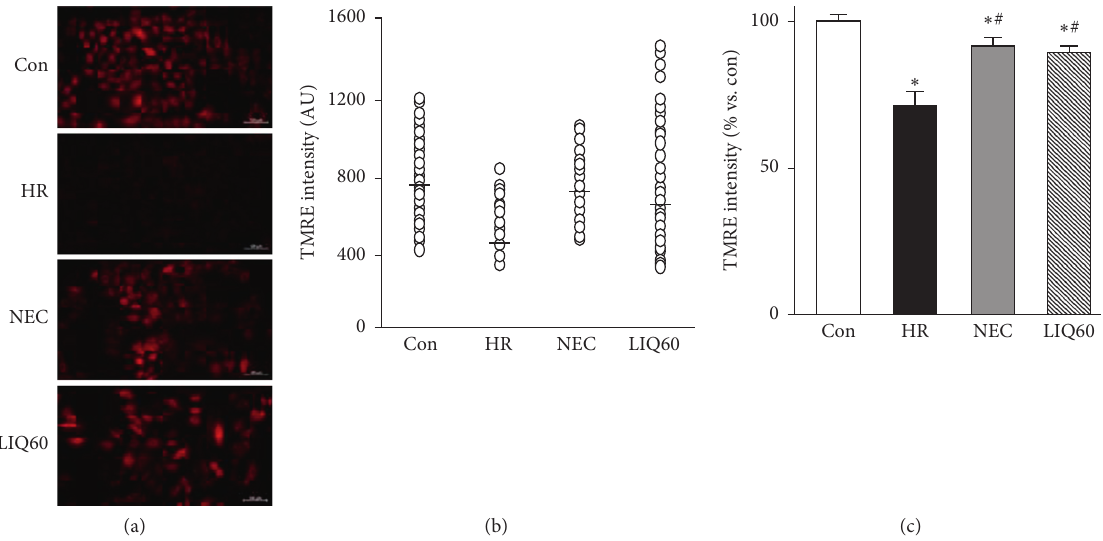
Figure 4: Mitochondrial function in H9C2 cells subjected to different treatments. (a) Representative images of H9C2 cells stained with tetramethylrhodamine ethyl ester (TMRE). (b) The graph indicates fluorescence intensity per cell ( ○ , open circle) of the representative images. (c) The graph indicates the total TMRE intensity; AU: arbitrary unit; Con: normal control; HR: hypoxia/reoxygenation; NEC: HR +NecroX-5; LIQ60: HR +LIQ at a dose of 60 μ M; ∗ p < 0 . 01 vs. Con; # p < 0 . 05 vs. HR; n � 3; scale bar 100 μ m.